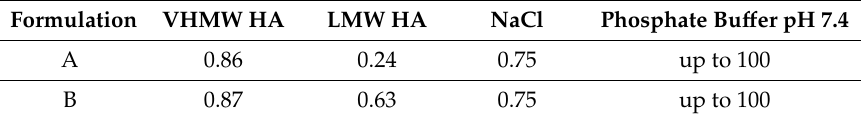
Table 4. % (w / v) composition of the two optimized formulations.